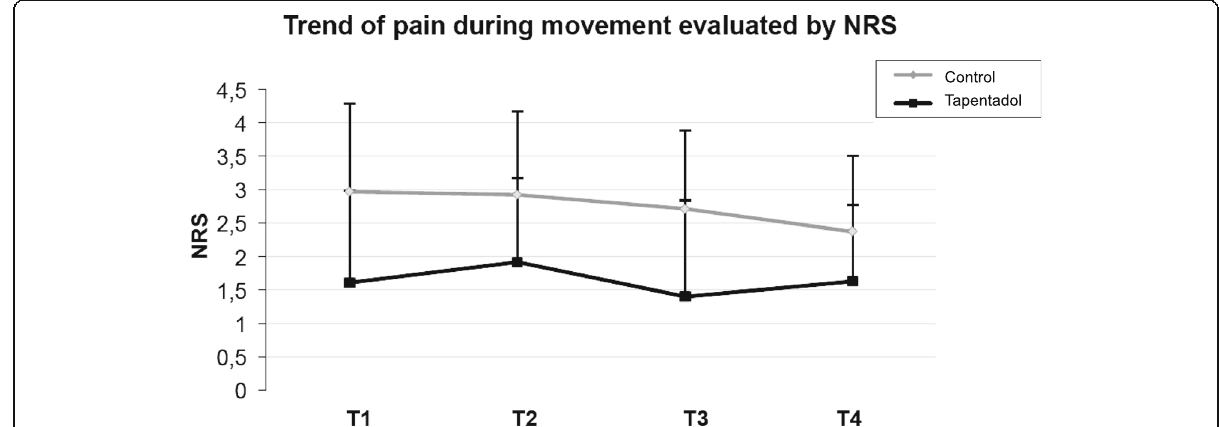
Fig. 2 Trend of pain during movement evaluated by NRS in the two treatment groups (Grey: control; Black: tapentadol)